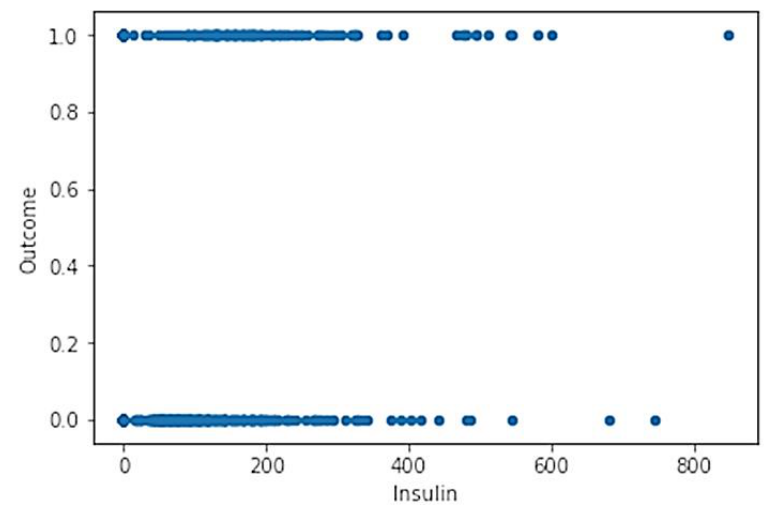
Figure 4. Outcome versus Insulin function.